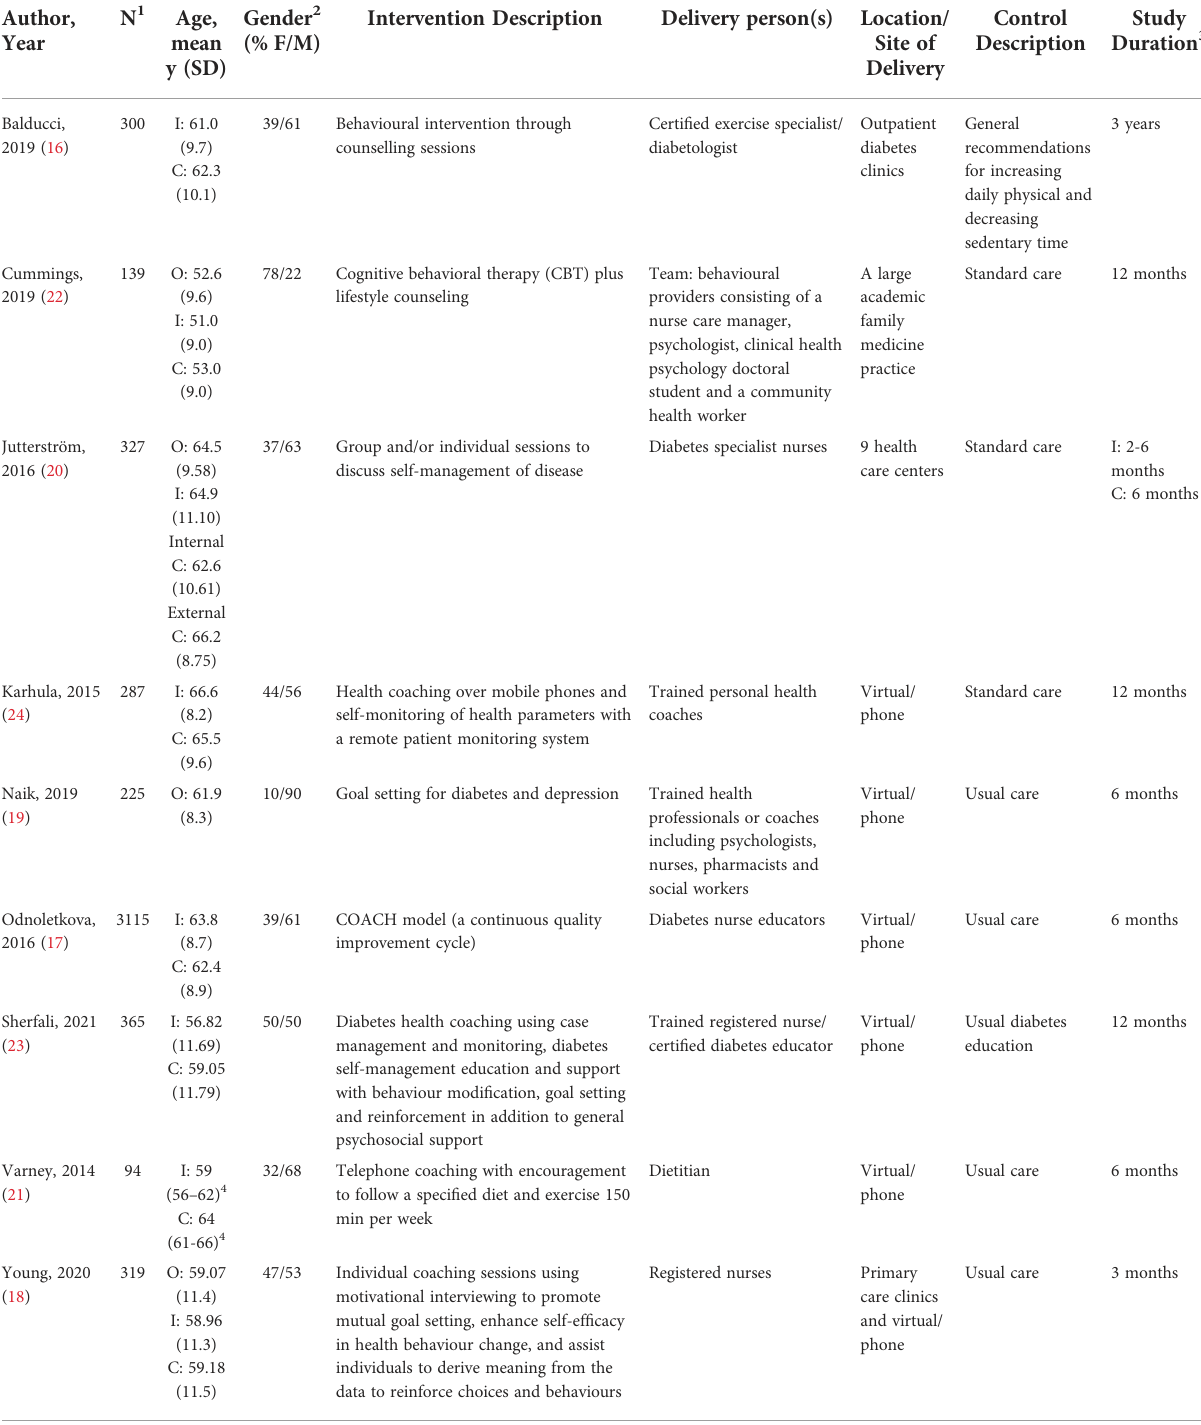
TABLE 1 Characteristics of included